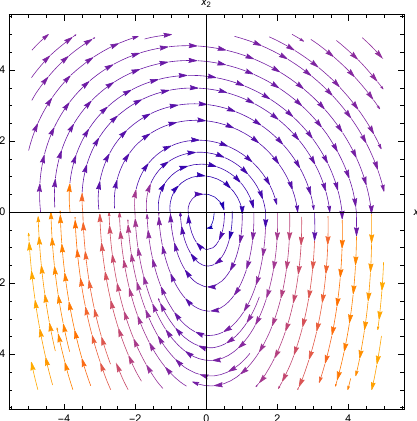
Figure 3. Local phase portrait of (52) for ε = 0.1, µ 1 = µ 2 = 1 and h ( x 1 ) = x 1 .